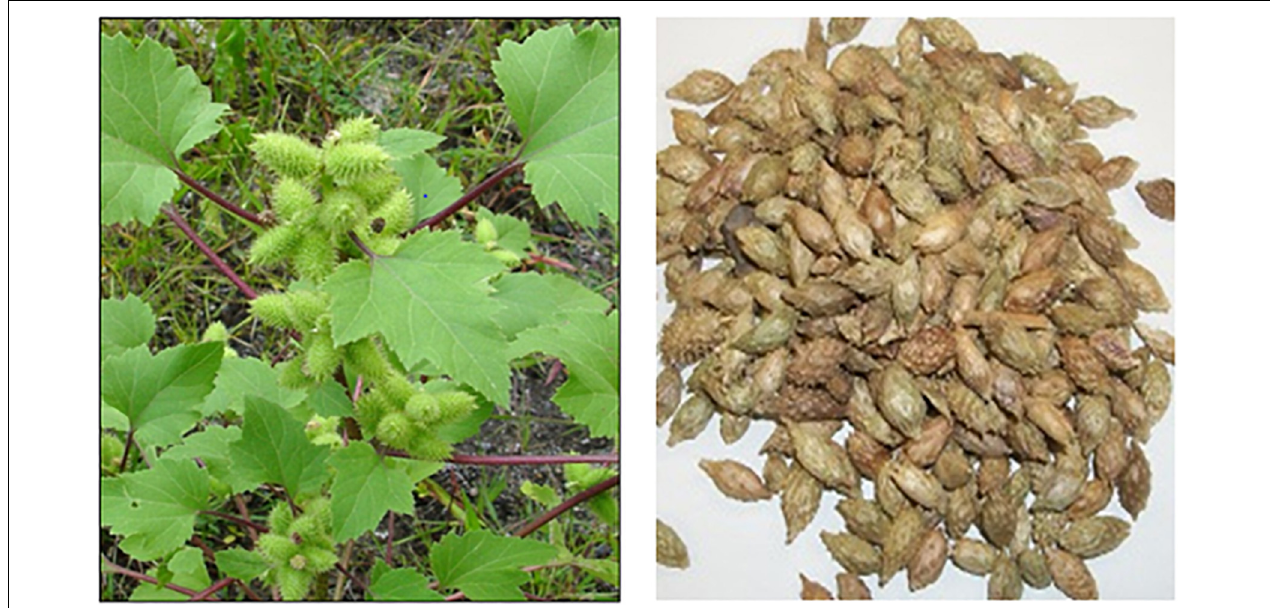
FIGURE 1 | (A,B) Field Photograph of Energy Crop Cocklebur Sp. ( Xanthium strumarium L.) and Dried